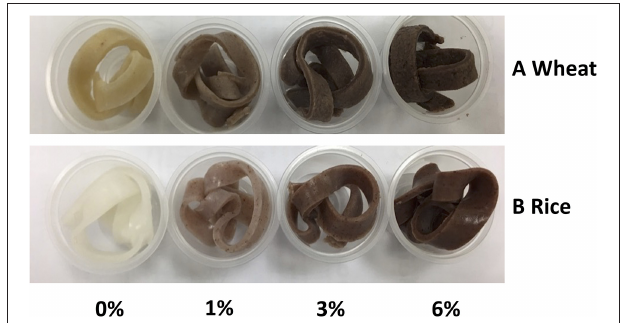
incorporated with EA extract of different dosages (0%, 1%, 3% and 6%).